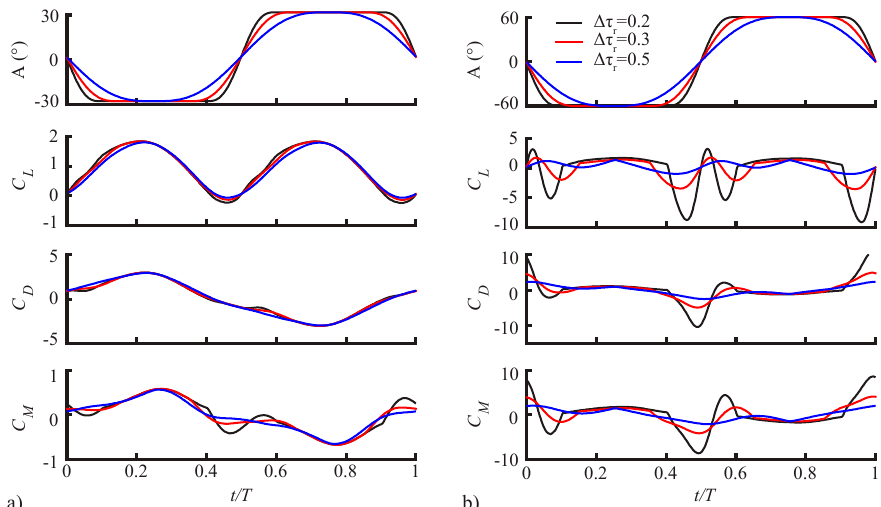
Figure 8. Plots of the predicted lift, drag, and moment coefficient for cases with changing pitching duration, Δ τ r = 0.2 (black), Δ τ r = 0.3 (red), and Δ τ r = 0.5 (blue). ( a ) Mild motion with A = 30° and x pa = 0.5; ( b ) Extreme motion with A = 60° and x pa = 1.0.